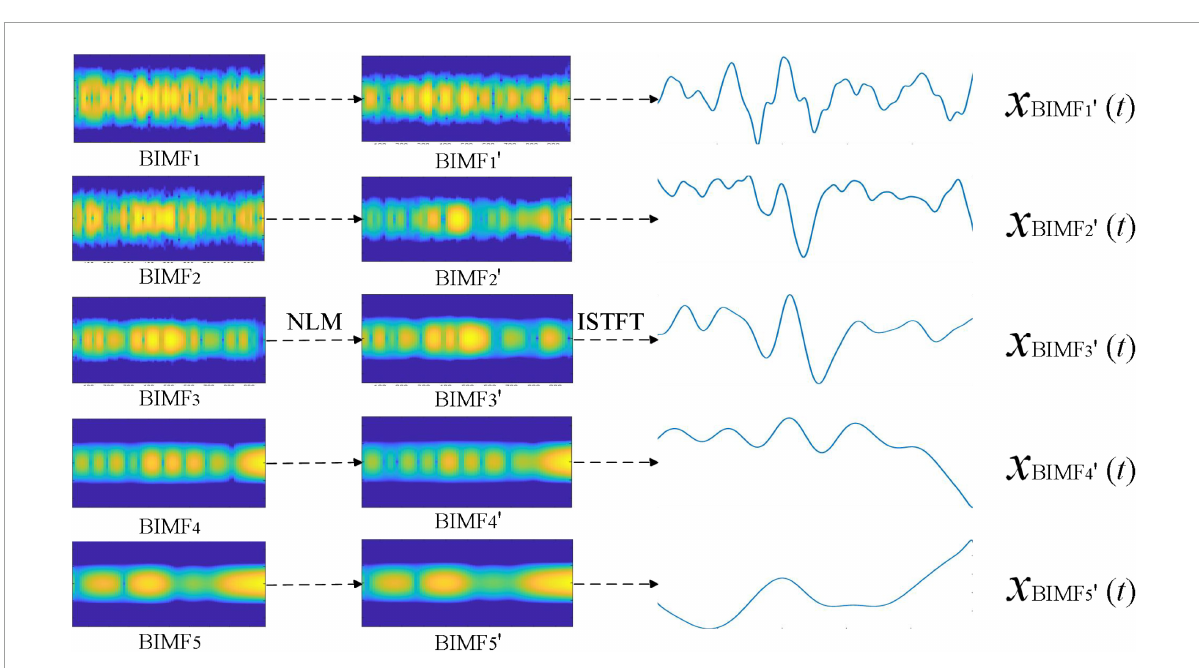
FIGURE3 The denoise results of sub time-frequency signals by non-local means (NLM).